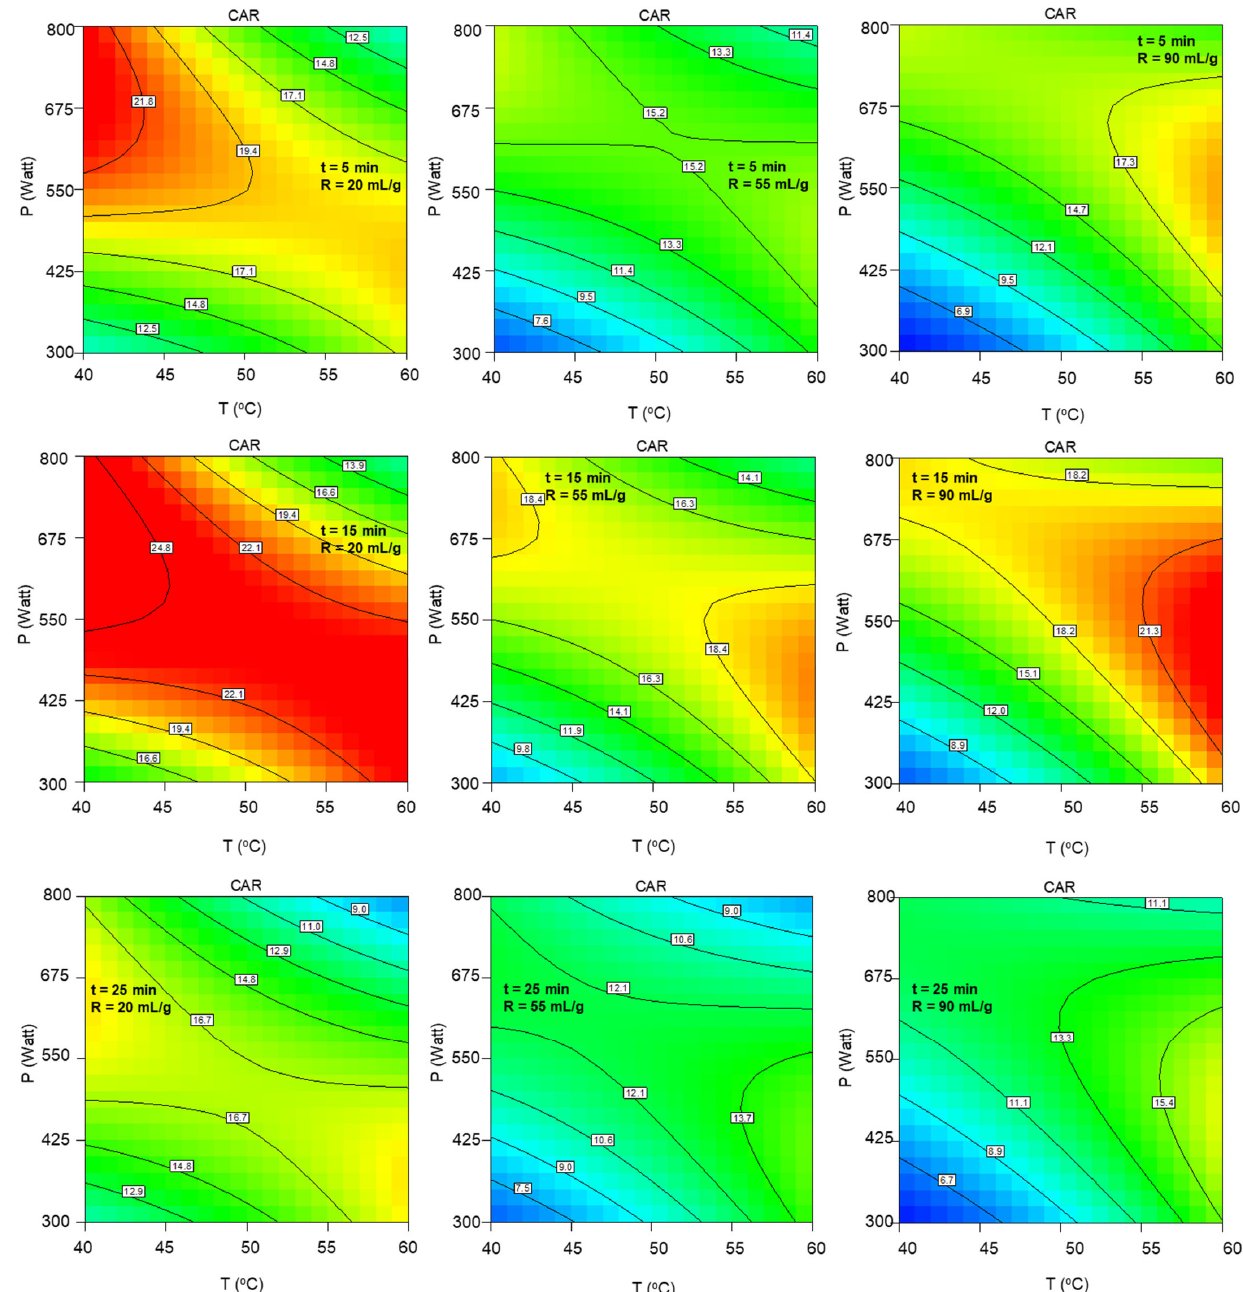
Figure A3. Contour plots of extract’s total carotenoid content as a function of extraction temperature and microwave power at the low, central and high levels of extraction duration and solvent-to- biomass